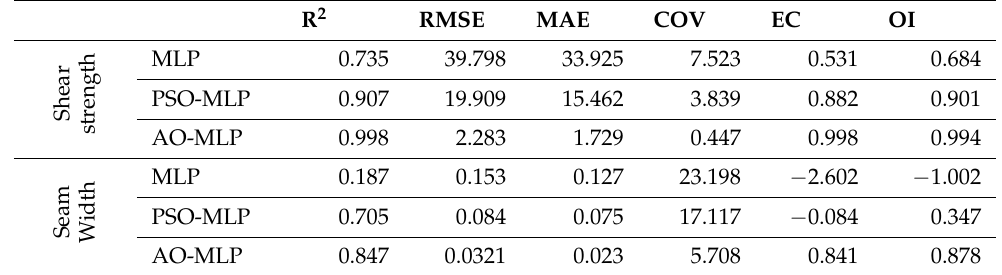
Figure 6. Radar diagrams of different statistical measures used to evaluate the performance MLP, PSO-MLP, and AO-MLP for: ( a ) shear strength and ( b ) seam width. Table 4. Different statistical measures used to evaluate the performance MLP, PSO-MLP, and